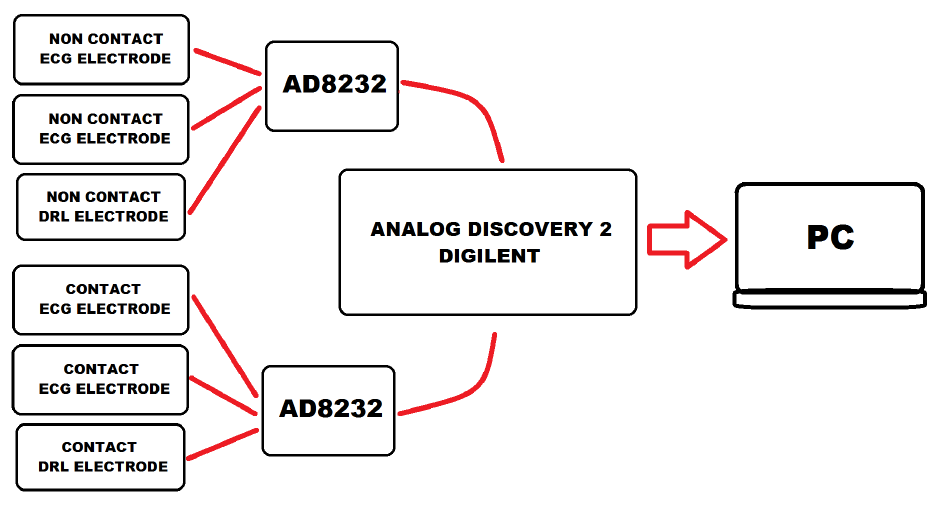
Figure 1. Measurement system enabling recording contact and non-contact